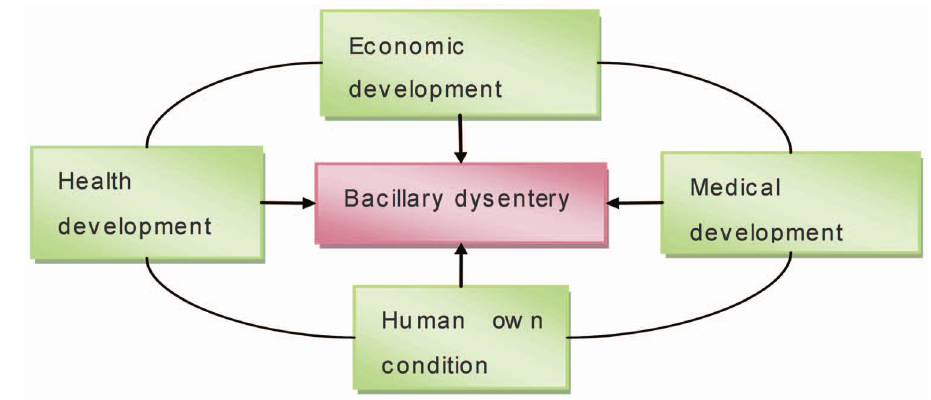
Figure 3. Socio-economic impact model of the occurrence and spread of bacillary dysentery. doi:10.1371/journal.pone.0102020.g003 PLOS ONE |